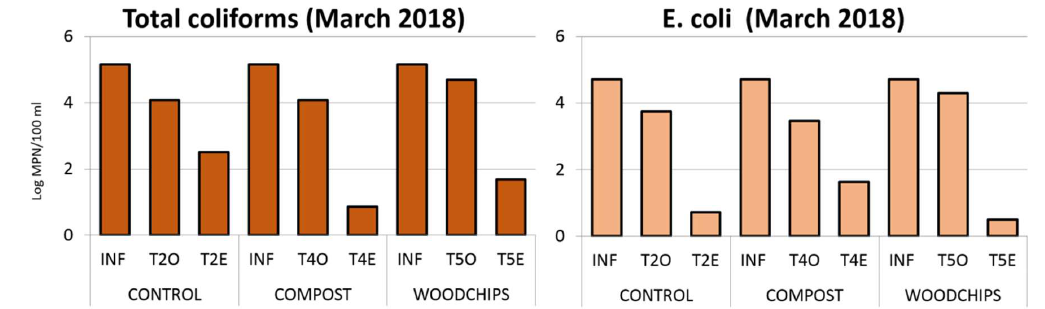
Figure 5. Concentrations (log MPN/100 mL) of total coliforms and Escherichia coli (E. coli)measured at the inflow (INF), immediately below the vadose zone (O-points), and effluent (E-points) of the reference system (T2, control) and the systems operating with reactive barriers based on compost (T4) and woodchips (T5) during the March 2018 recharge episode.